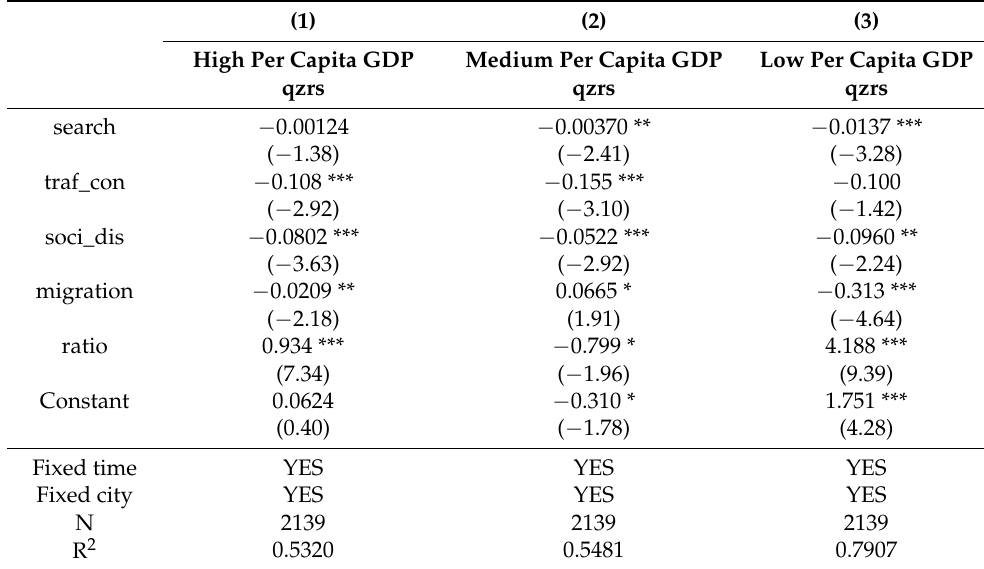
Table 7. Heterogeneity test results of per capita GDP.